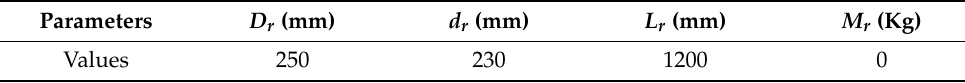
Table 3. Equivalent structural parameters of rotor.